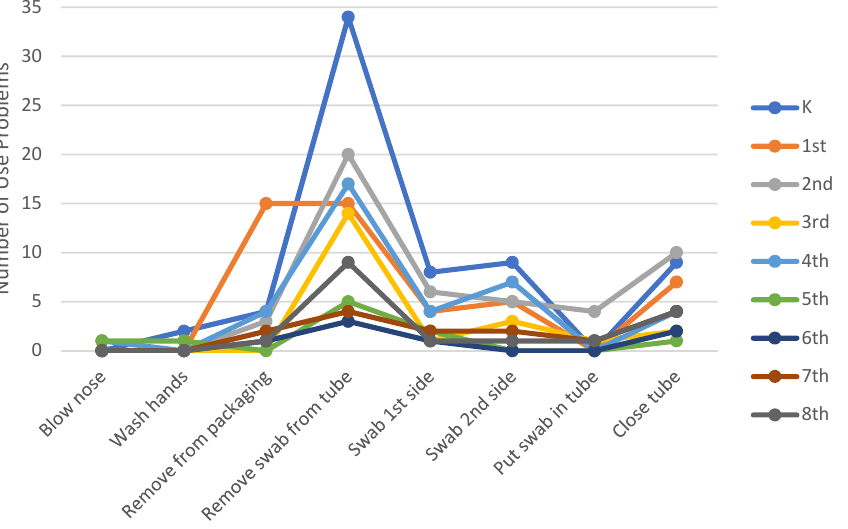
Figure 7. Number of use problems per task by grade in Phase 4 using XpressCollect.